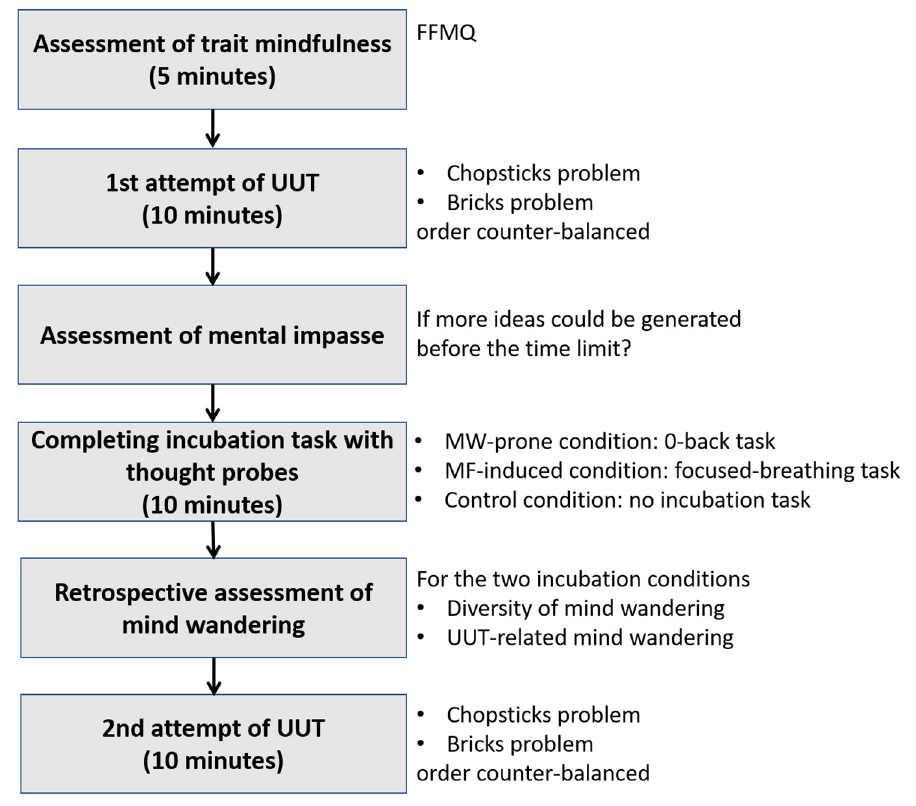
Fig 1. The general procedures of the